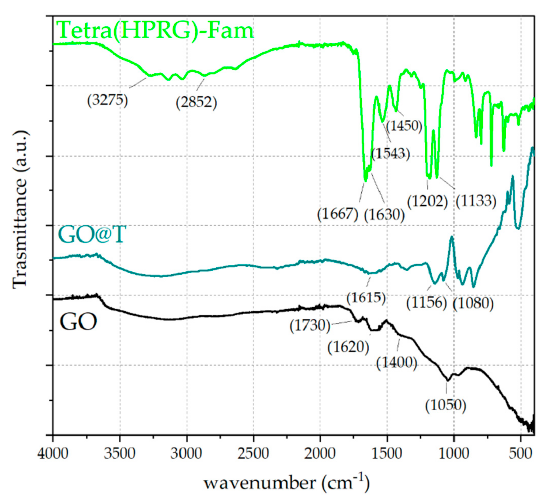
Figure 4. Attenuated total reflectance Fourier transform infrared (ATR/FTIR) spectra of graphene oxide (GO) (black curve), Tetra(histidine-proline-rich glycoprotein (HPRG))-Fam (green curve) and GO@T (dark cyan curve) hybrid samples.